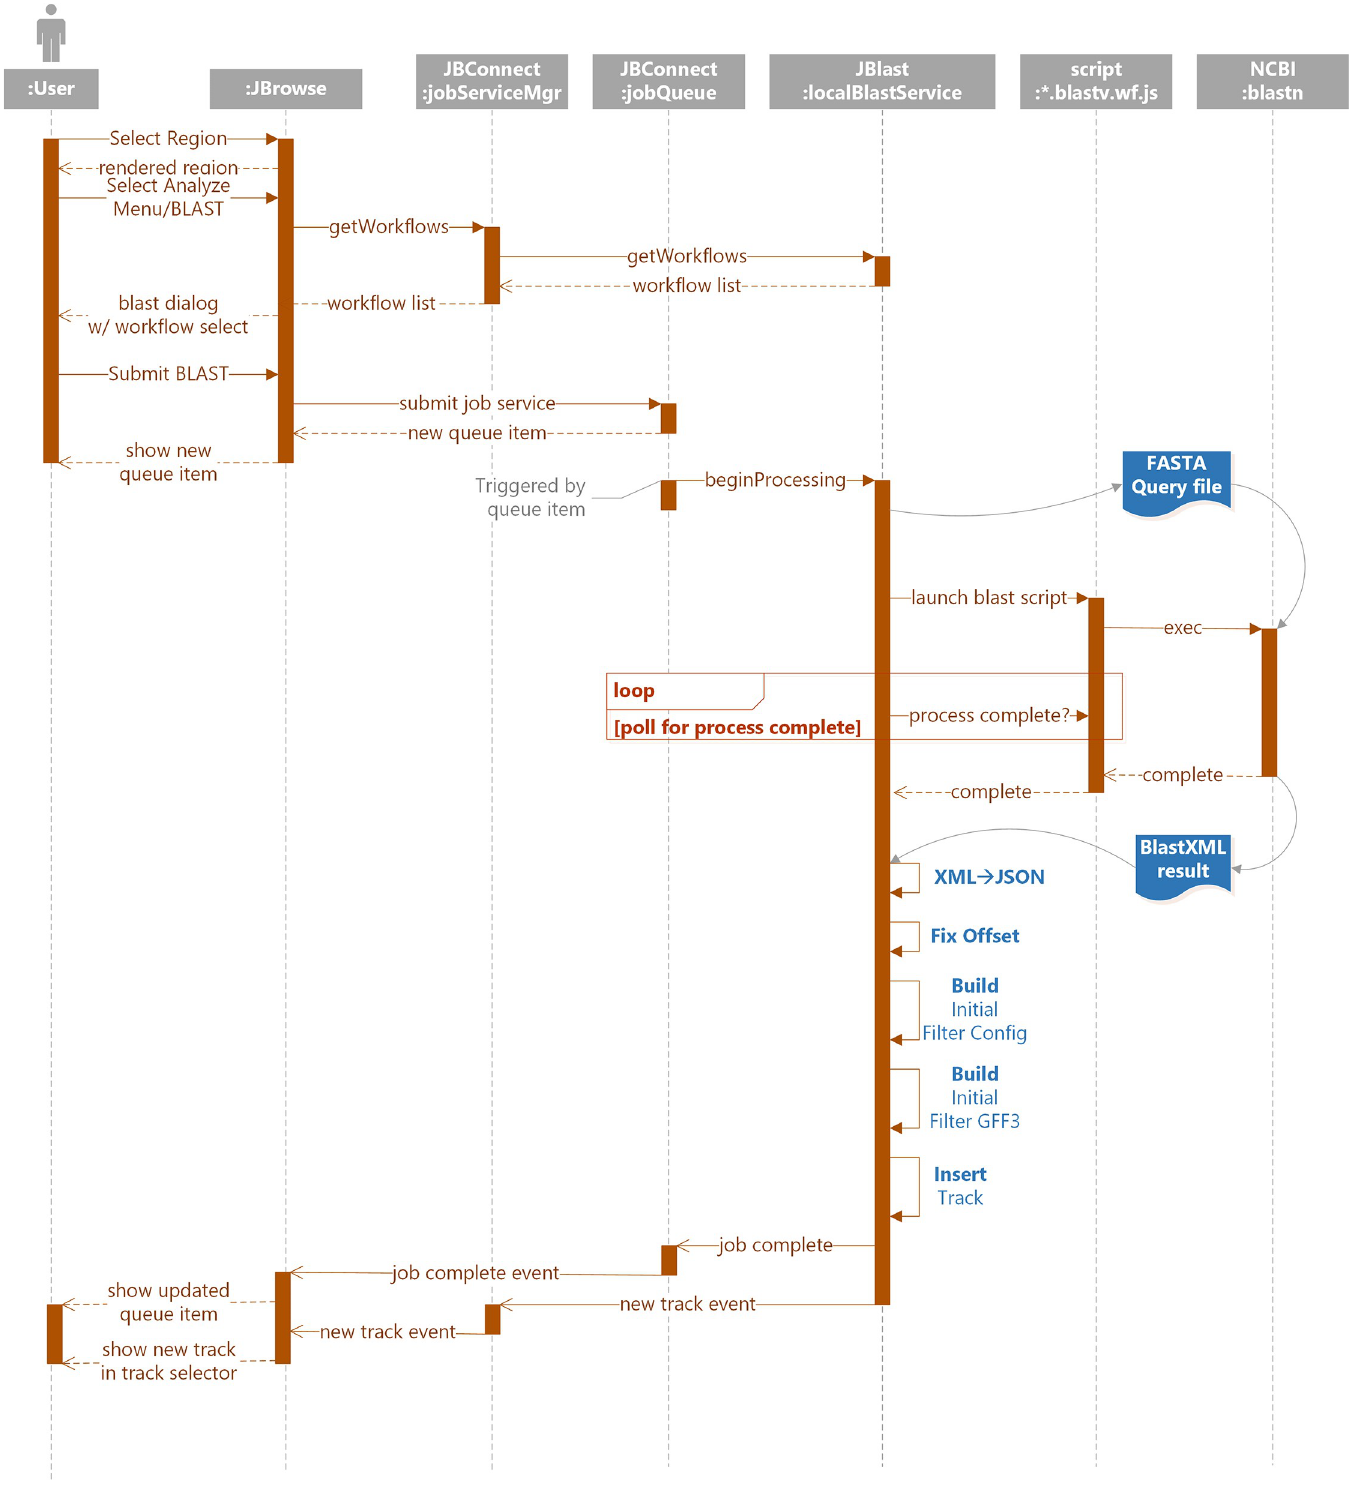
Fig 5. Interactions for the standalone BLAST workflow flow from the user, via the JBrowse client, through the JBConnect server, and into the JBlast module, which then runs NCBI BLAST locally on the server, processes and packages the results, and returns them to the user.